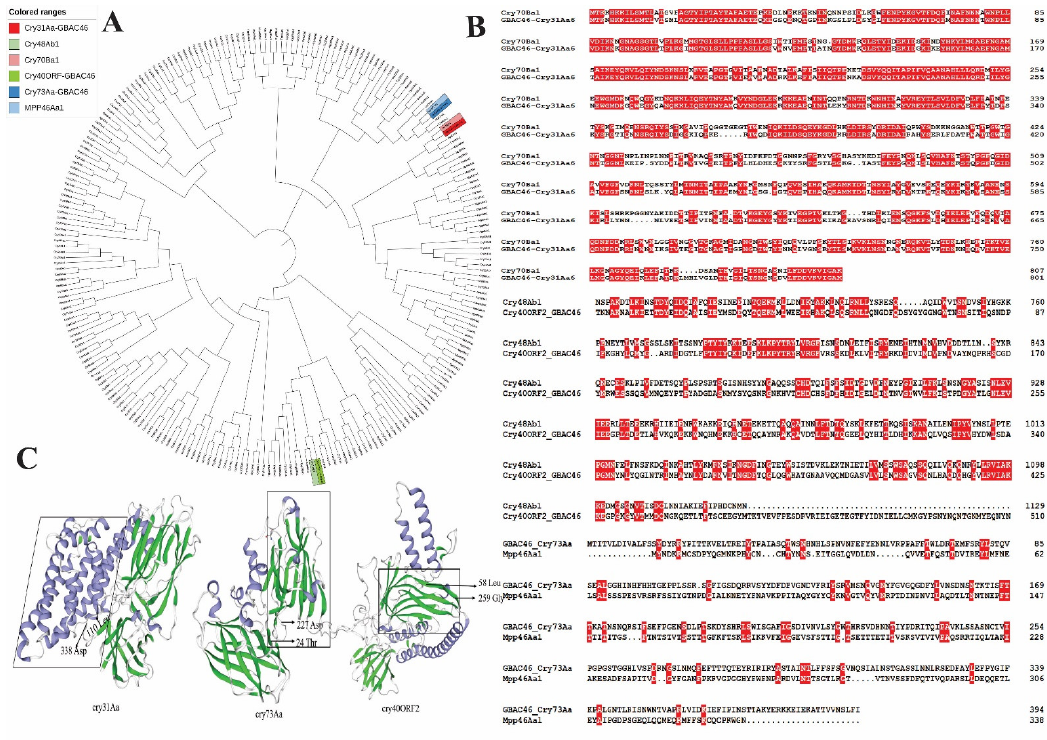
Figure 1. Phylogenetic tree construction was based on the sequence alignment of full-length Cry31Aa and familiar Cry protein ( A ); the amino acid sequences alignment of the Cry31Aa, Cry73Aa, and Cry40ORF proteins ( B ); three-dimensional structure prediction of the three Cry proteins in the GBAC46 strain ( C ).